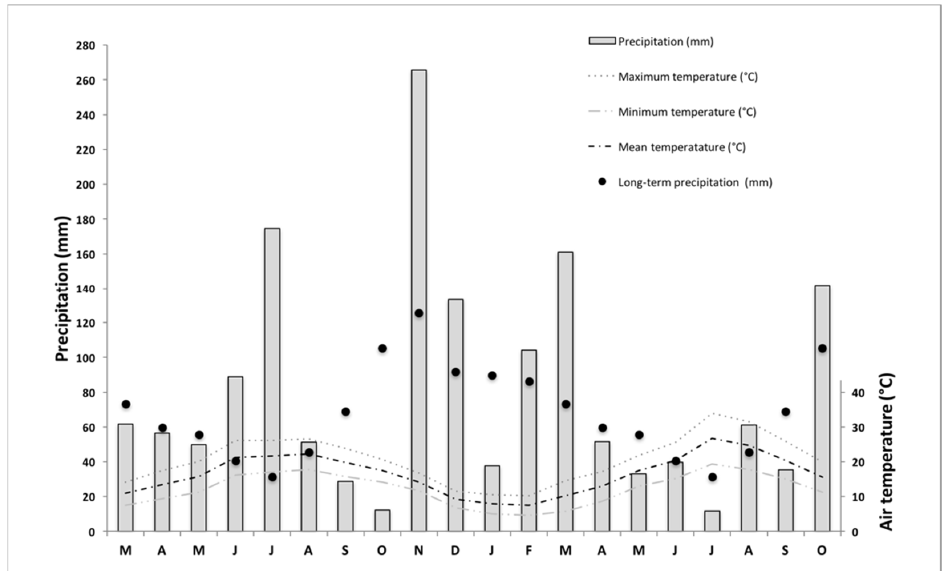
Figure 2. March 2014–October 2015 and long-term 1971–2000 monthly rainfall, minimum, mean and maximum monthly air temperature in Manciano (Grosseto, Italy). The graph is presented according to Bagnouls and Gaussen [42], in order to identify the occurrence of dry condition, i.e., when rainfall is equal to or lower than twice the monthly mean air temperature.